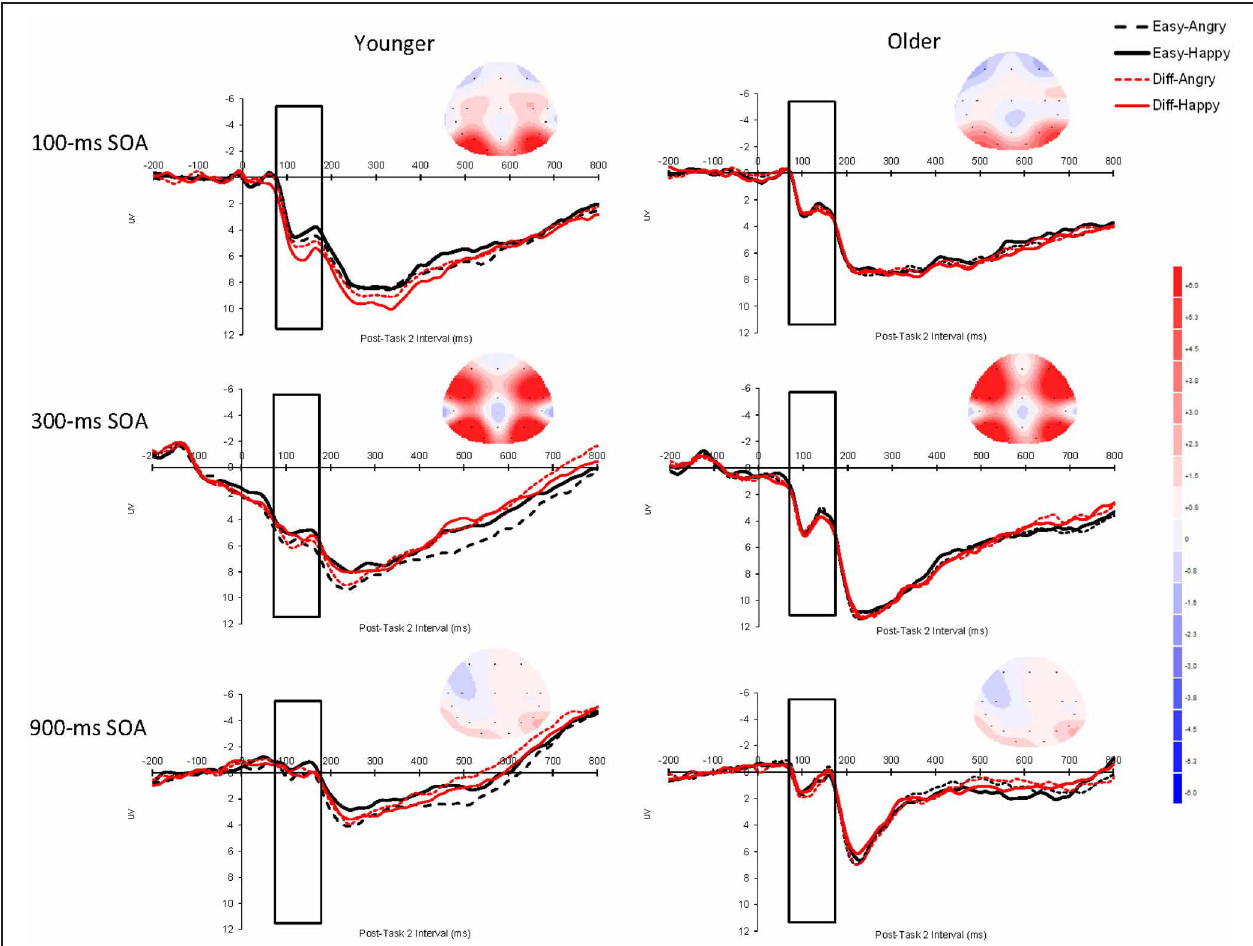
assess P1 (70–170ms after Task-2 stimulus onset). The scalp topography of the ERPs was obtained during the time window 70–170ms after Task 2 stimulus onset for each SOA. The baseline period was the 200ms prior to Task-2 stimulus onset. Negative is plotted upward and time zero represents Task-2 stimulus onset. SOA: stimulus onset